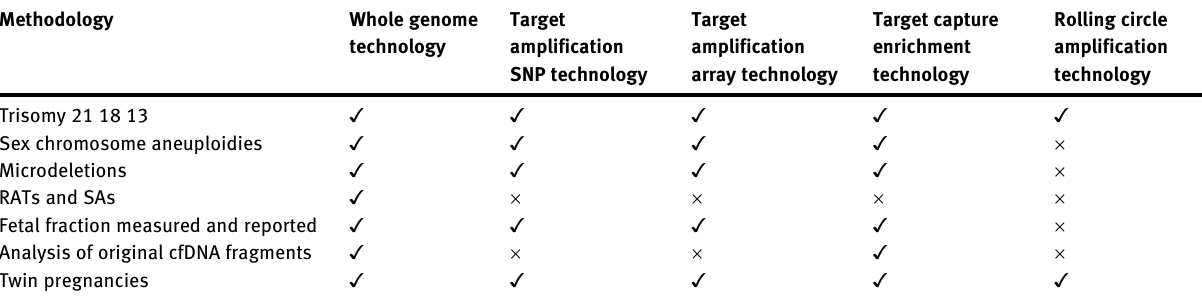
Table  : NIPT technologies comparison.